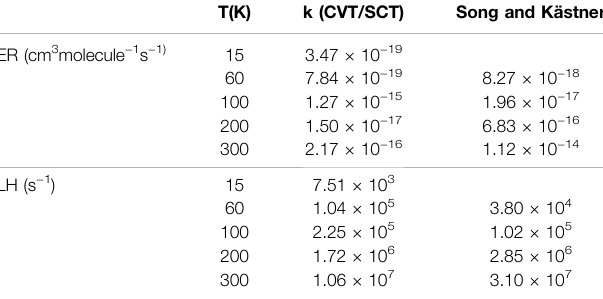
TABLE 6 | Calculated rate constants at selected temperatures.